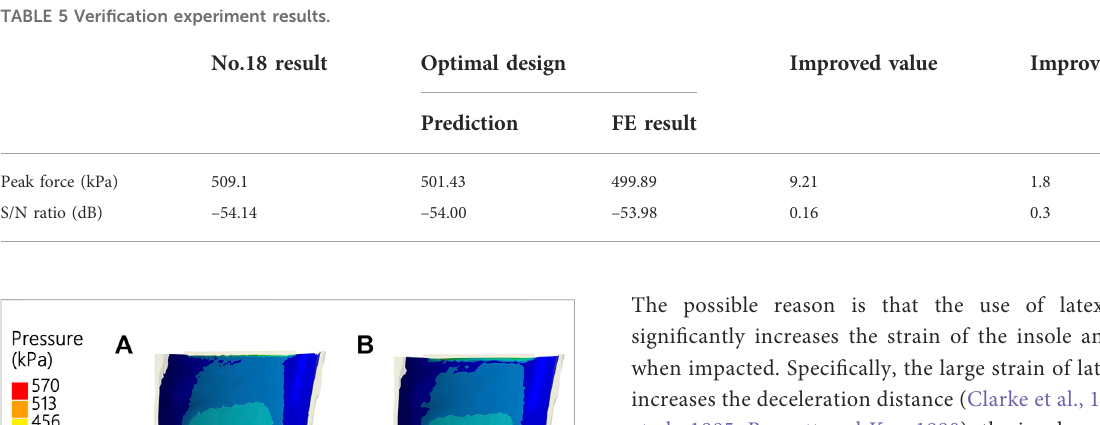
TABLE 5 Veri fi cation experiment results.